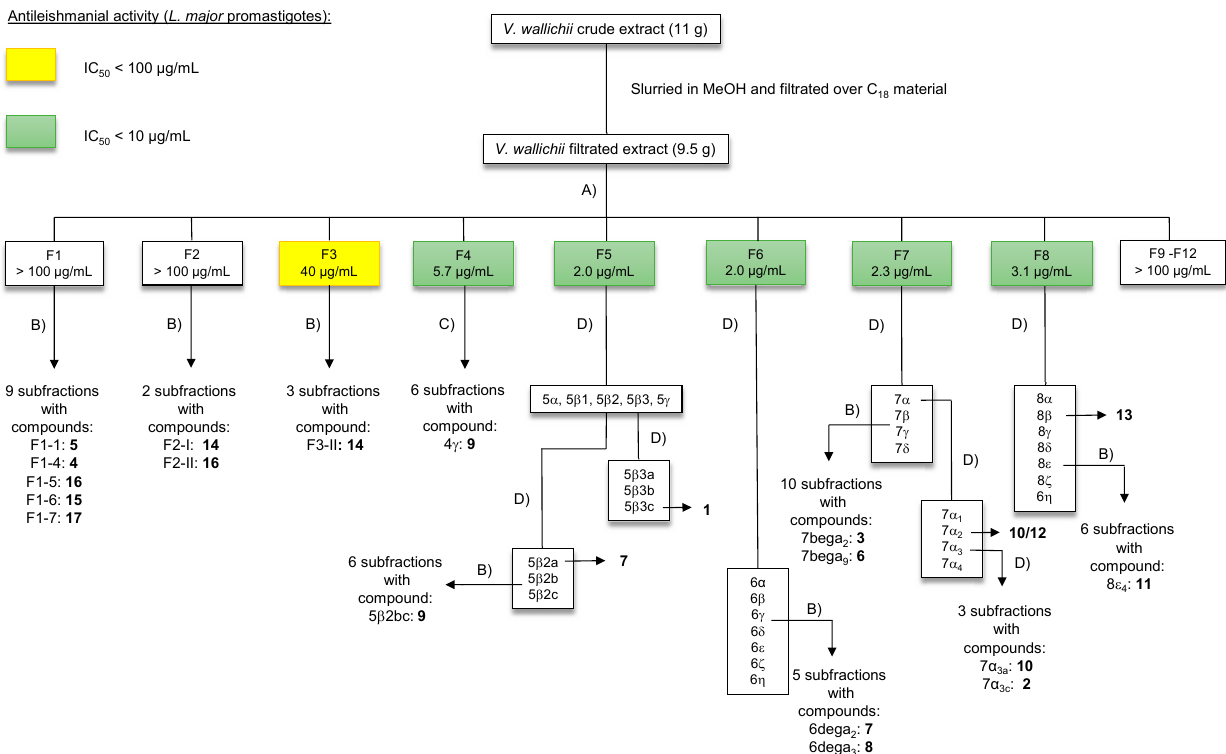
Figure 2. Overview of the bioassay-guided fractionation of V. wallichii extract. Method A : preparative HPLC (250 mm × 10 mm, 5 µm, Nucleosil 100-5); H 2 O (a): MeOH (b), gradient: 70% b (0 min), 75% b (7 min), 100% b (25 min), 70% b (30 min); flow rate: 3.3 mL/min. Method B : preparative HPLC (125 mm × 10 mm, 5 µm, Nucleodur Sphinx RP); H 2 O (a): CH 3 CN (b), gradient: 10% b (0–2 min), 30% b (2–15 min), 65% b (15–22 min), 10% b (22– 24 min); flow rate: 4.4 mL/min. Method C : flash chromatography (silica gel; MeOH/CHCl 3